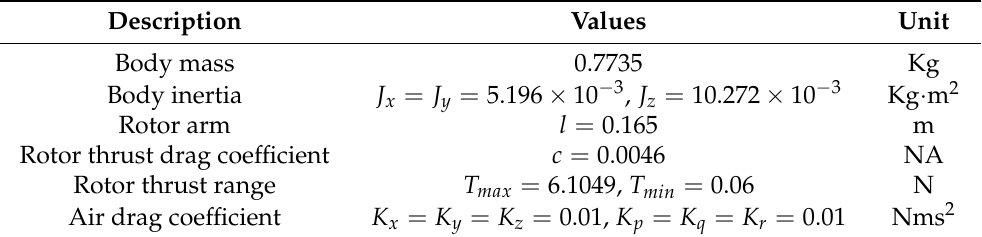
Table 1. Physical parameters of the quadrotor